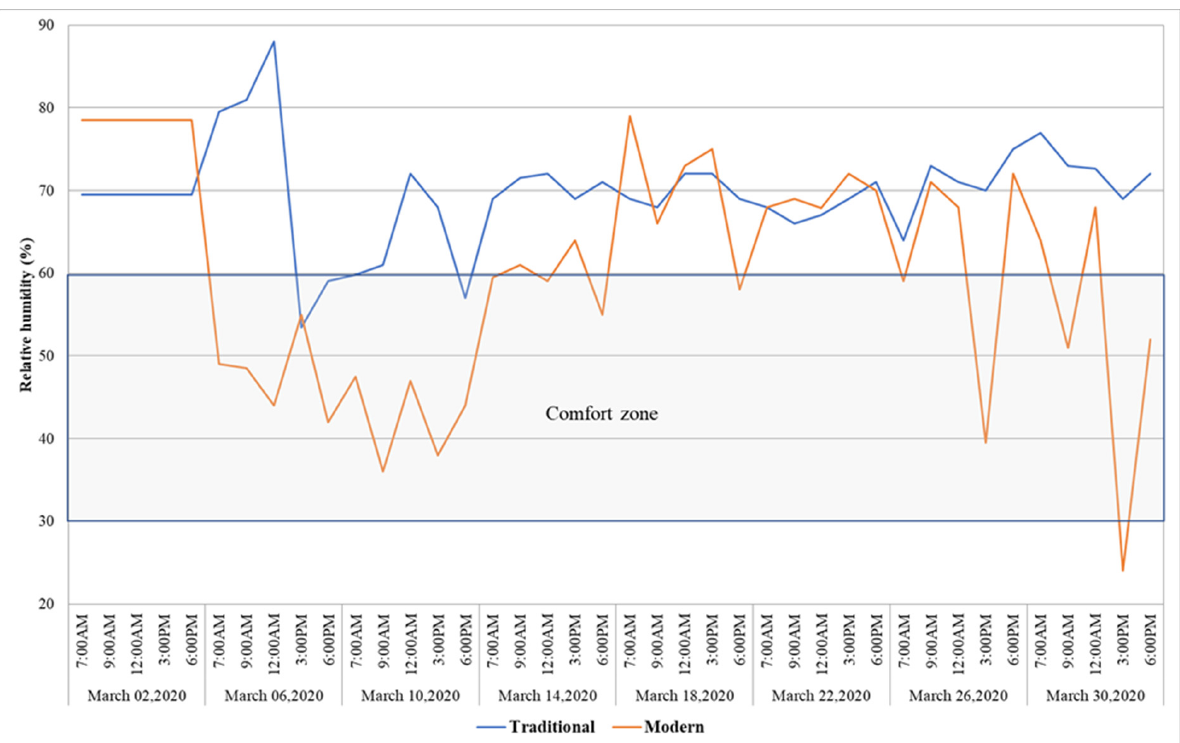
Figure 25. Humidity data from March 2020.